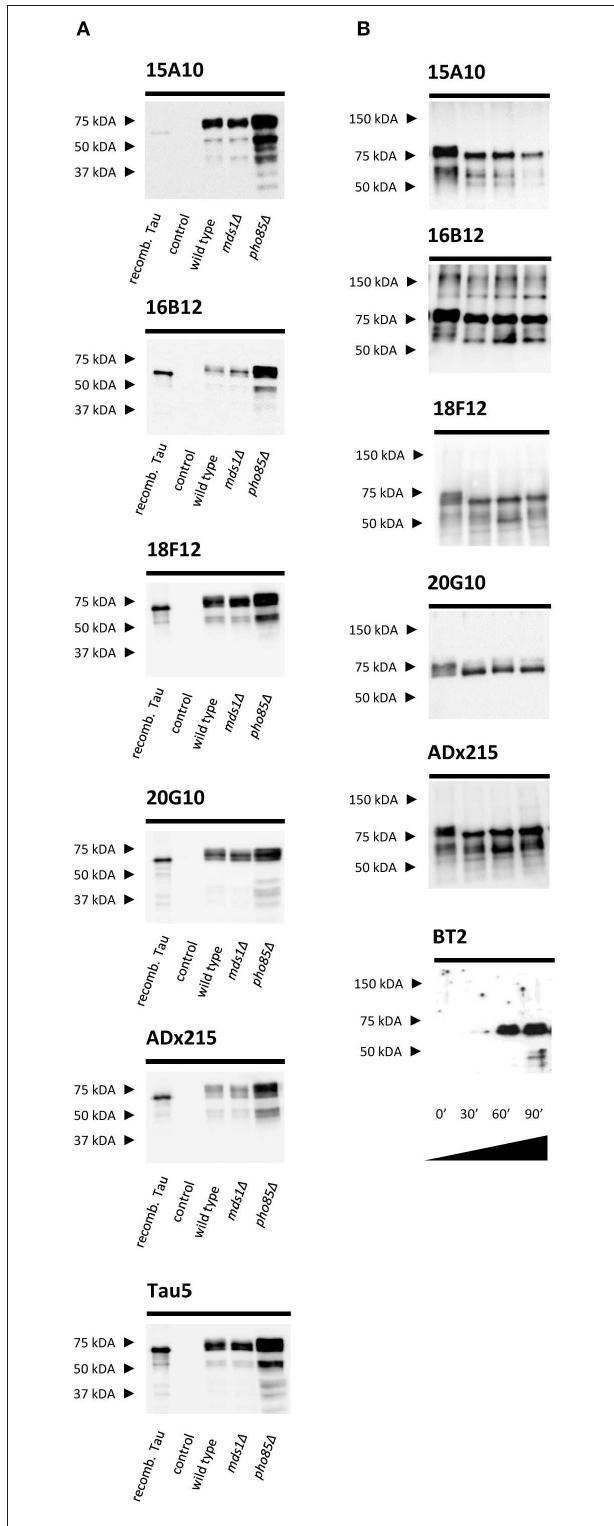
FIGURE 1 | Characterization of the novel mAbs in yeast. (A) Western blot analysis of total protein extracts from different BY4741 yeast